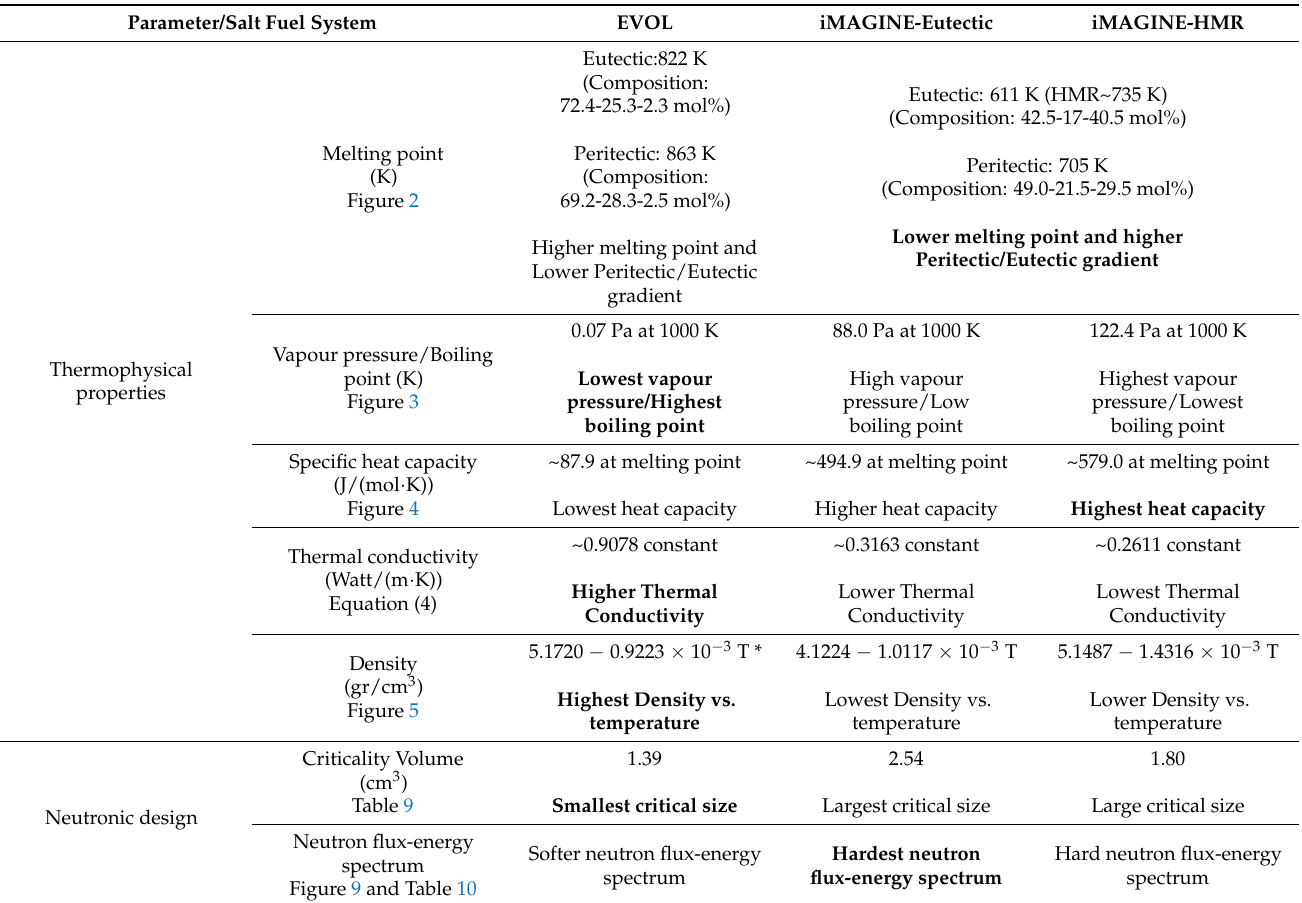
Table 11. Conclusion of thermophysical properties and neutronic criticality for EVOL (fluoride-based) and iMAGINE (chloride-based)